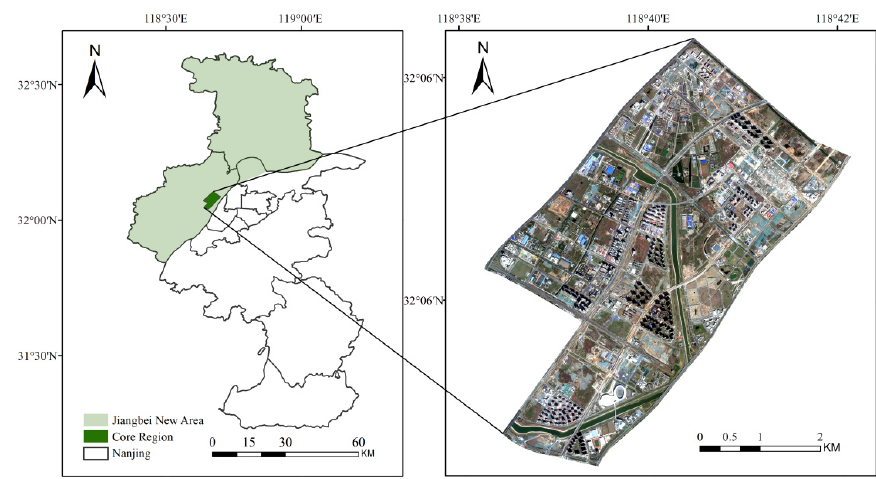
Figure 1. The spatial location of the Core Region of Jiangbei New Area.